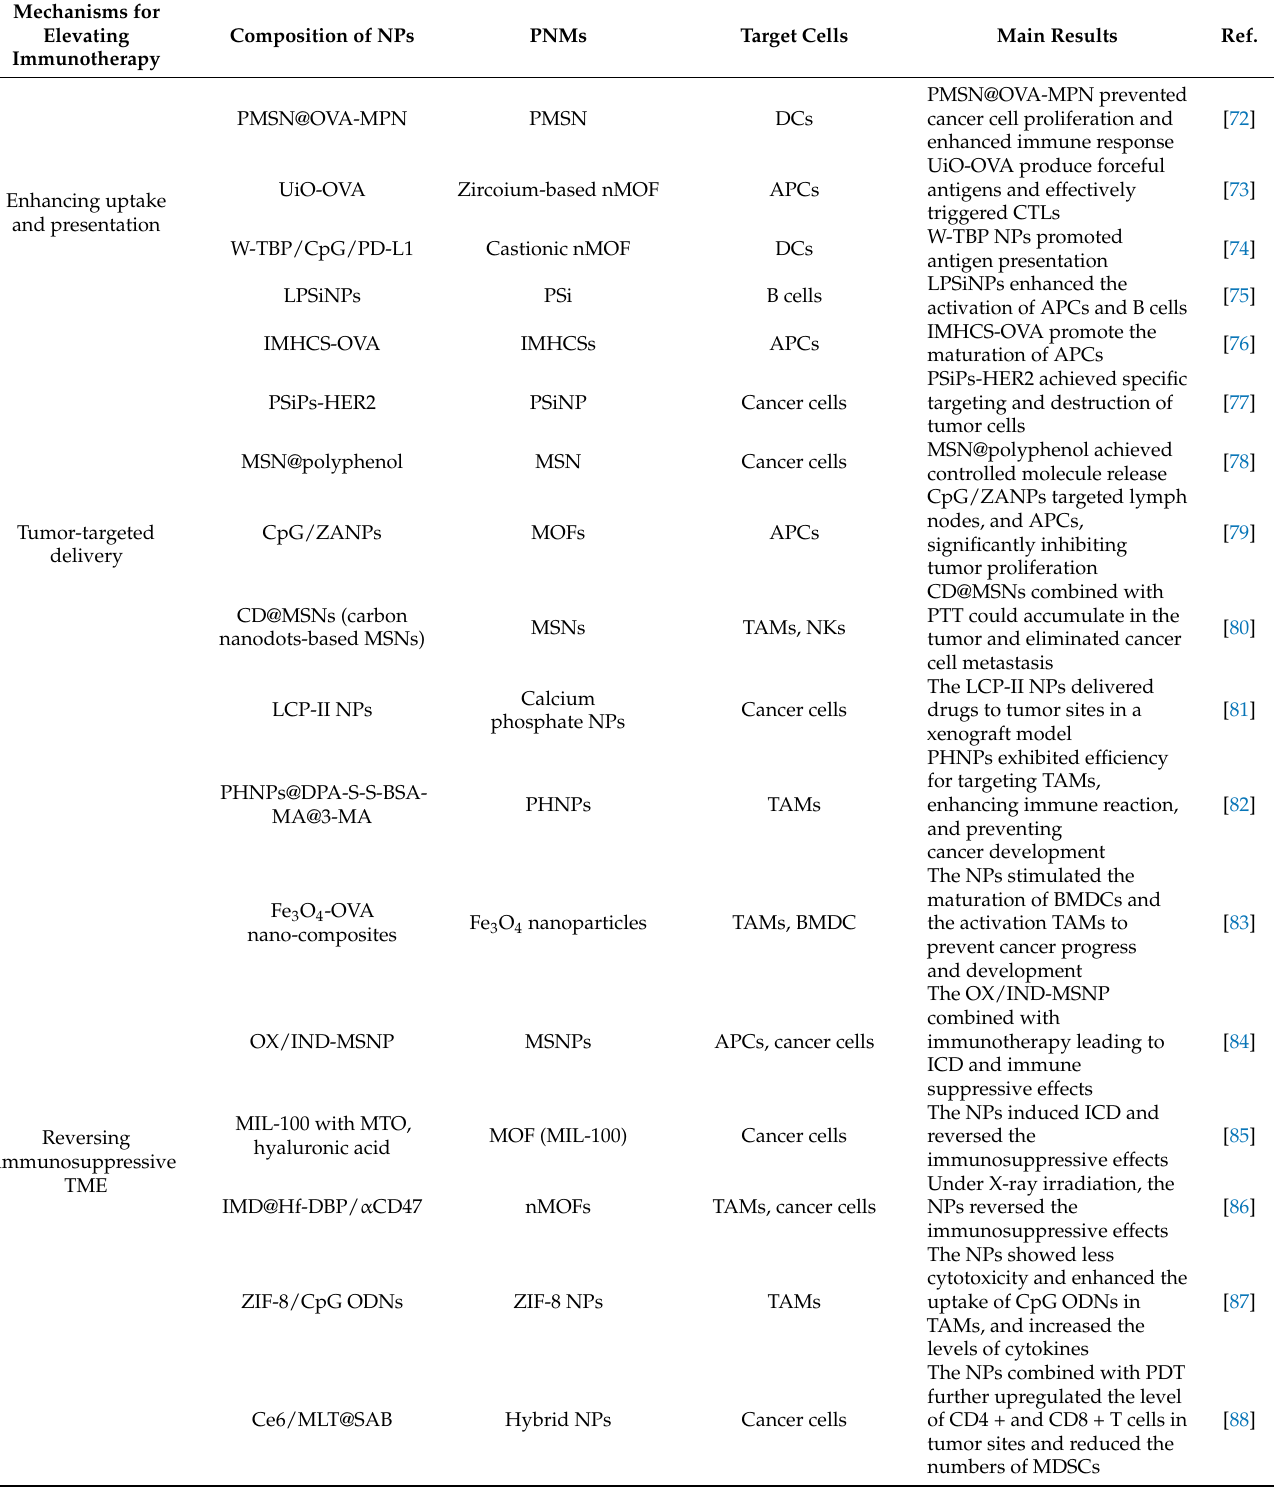
Table 3. The main characters of nanoparticles mentioned in this review, were